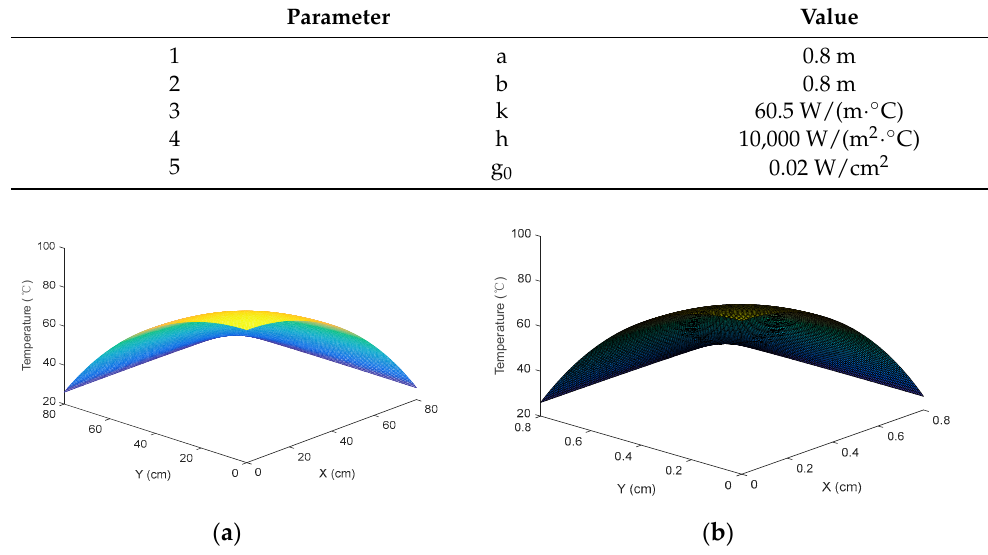
Table 3. Comparison of the upper and lower limits of the temperature field.